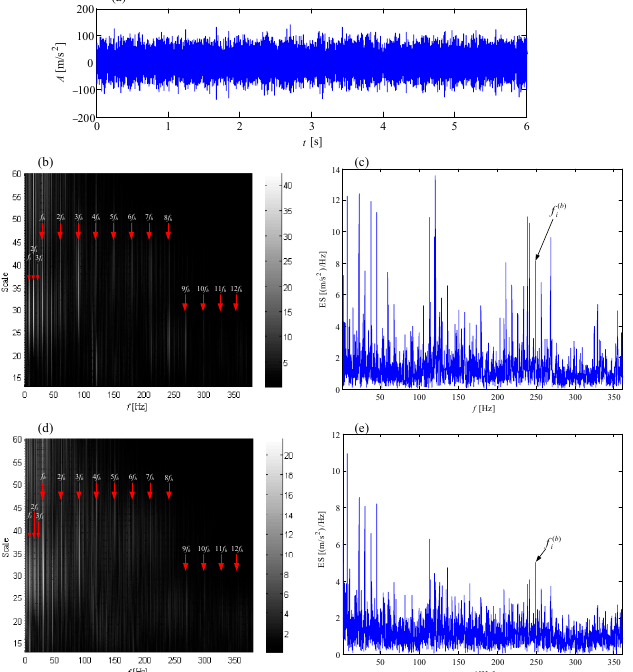
Figure 27. Multiscale enveloping spectrogram: ( a ) vibration signal from faulty gear pair and rear bearing; ( b ) MuSEnS before cepstrum pre-whitening; ( c ) slice of the MuSEnS at scale 20; ( d ) MuSEnS after cepstrum pre-whitening; ( e ) slice of the MuSEnS at scale 20.